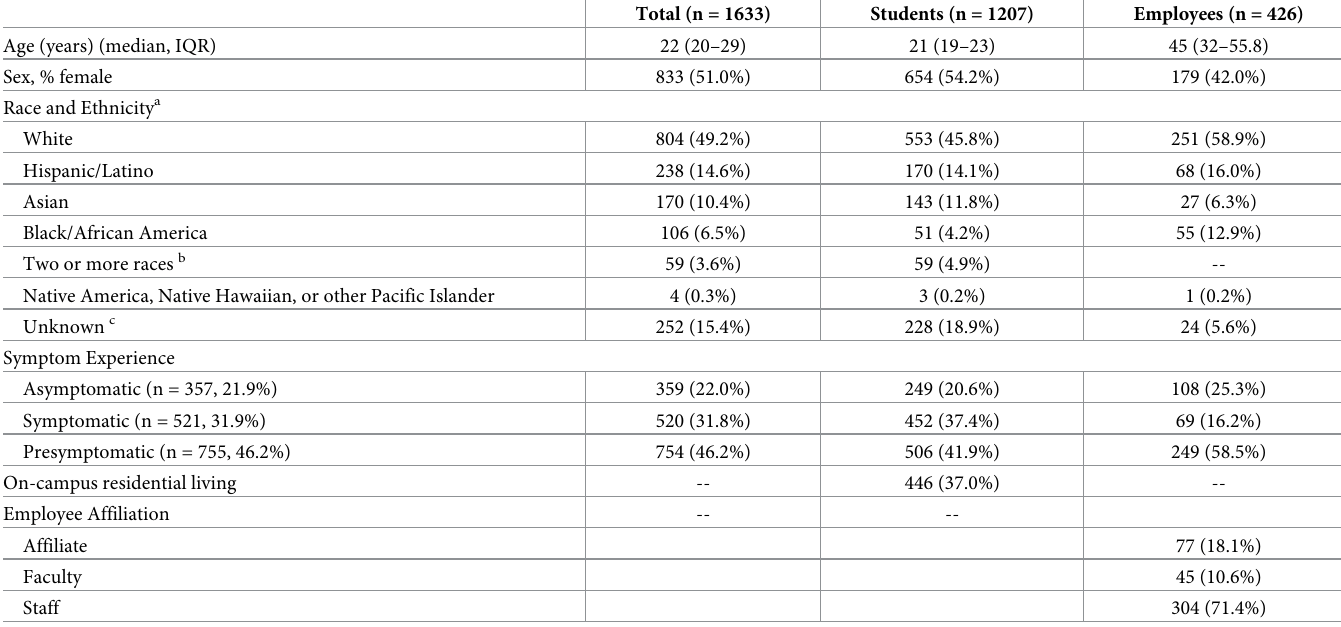
Table 1. Study population-